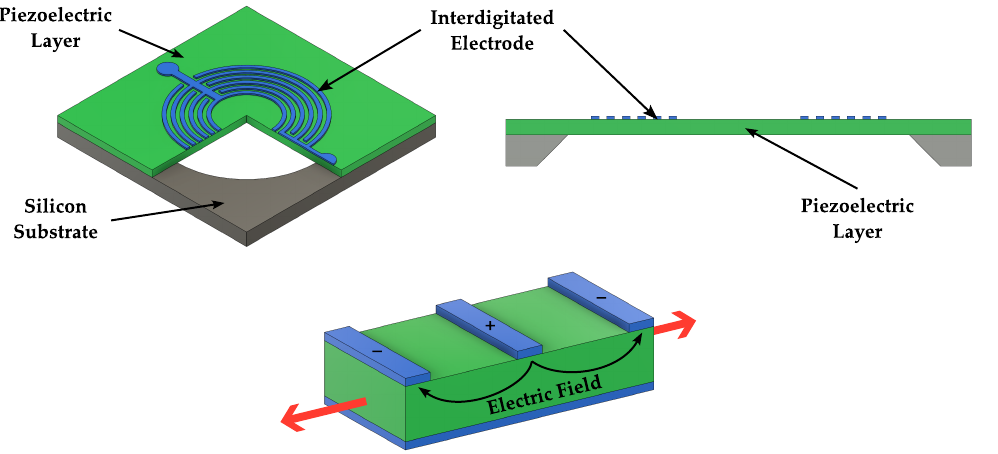
Figure 6. Schematic 3D view and cross section of a piezoelectric speaker exploiting the d 33